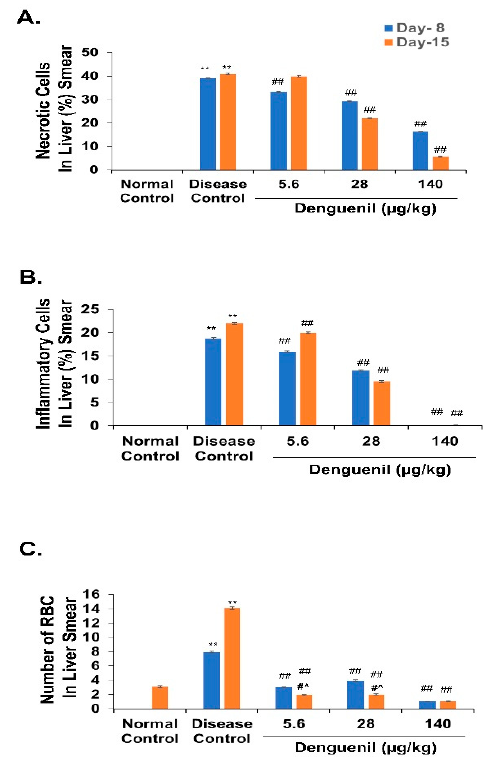
Figure 3. Denguenil treatment inhibits hepatic cell necrosis and inflammation, and red blood cell (RBC) infiltration into liver. H&E staining and analysis was performed on liver smears from di ff erent groups at the 8th day and 15th day time points. Percentage necrosis, inflammation, and RBCs present in liver smear were quantified. ( A ) Denguenil treatment inhibited the dengue-virus-induced hepatic cell necrosis in a dose-dependent manner with the maximum protection at 15th day time point in the 140 µ g / kg group. ( B ) Denguenil treatment inhibited the dengue virus induced liver inflammation in a dose-dependent manner. ( C ) RBC infiltration into liver was inhibited upon Denguenil treatment. n = 24, data are presented as means ± SEM. **, ##, #ˆ p < 0.001. ** Represents significant compared to Normal Control; ## Represents significant compared to their respective Disease Controls; #ˆ Represents significant among two time points.